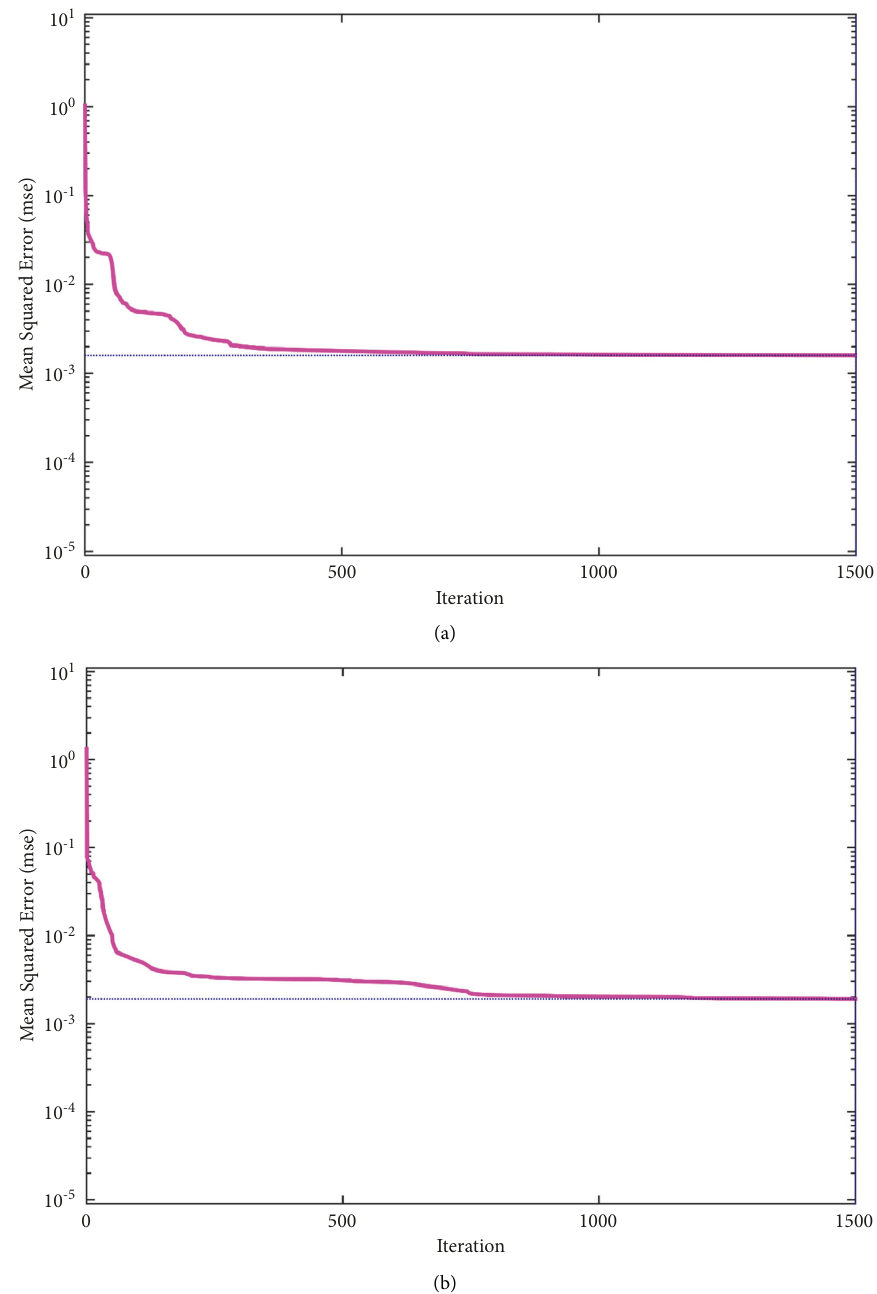
Figure 1: Mean squared error values according to the number of iterations for two parameters TC ratio and relative